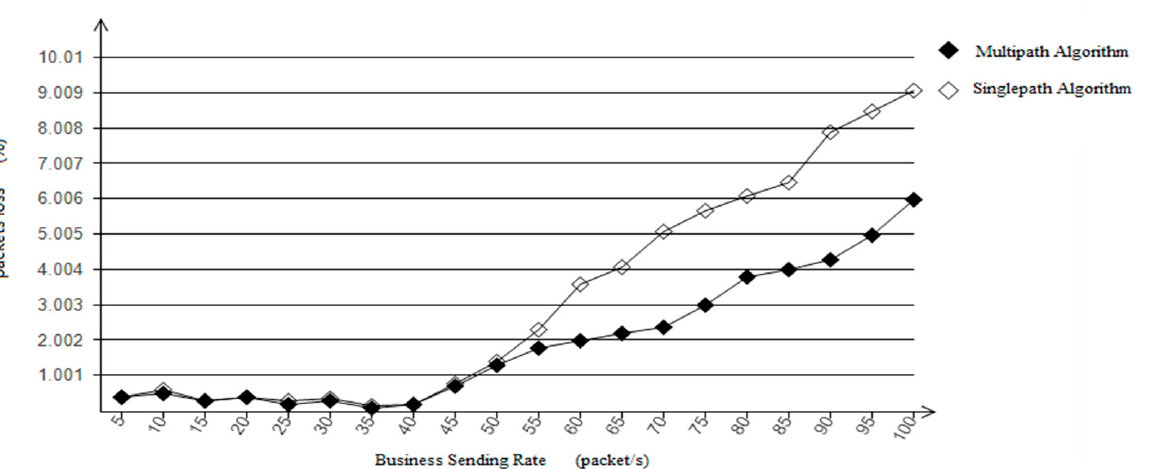
Figure 9. Packets loss comparison chart.